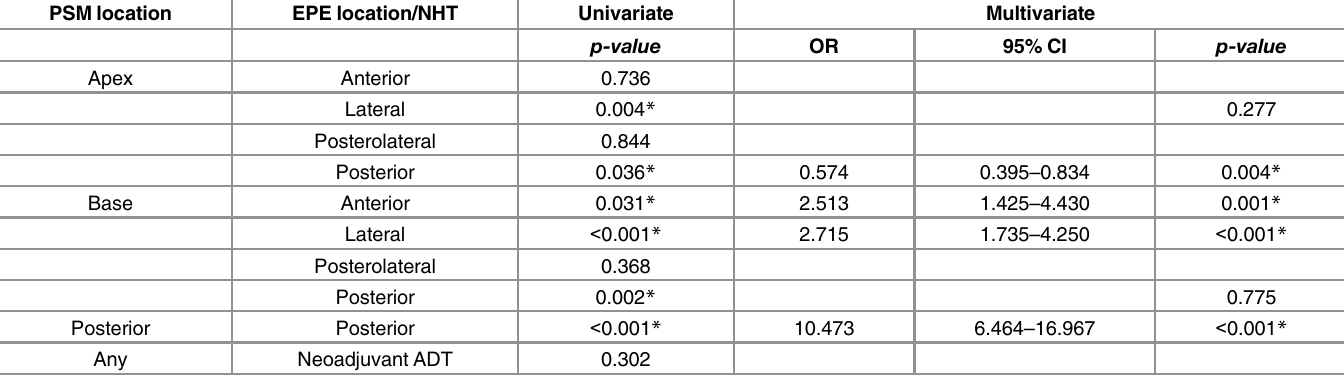
Table 4. Logistic regression for apex and base PSM. Note higher odds of anterior, lateral EPE for the base PSM. Effect of neoadjuvant ADT on PSM was not statistically significant. PSM location